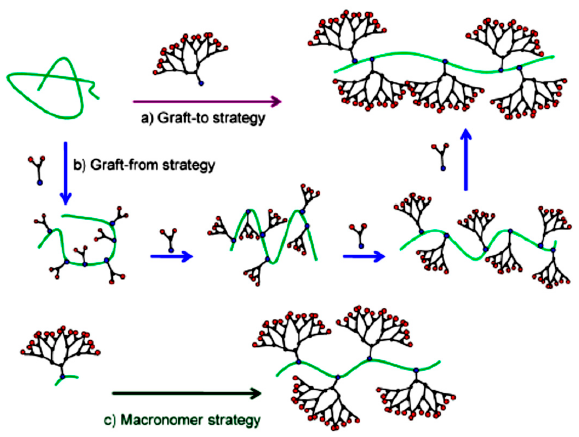
Figure 1. Schematic illustration of the three general synthetic strategies for dendronized polymers: ( a ) graft-to; ( b ) graft-from; ( c ) macromonomer route. Reproduced from Julieta I. Paez et al. [3].